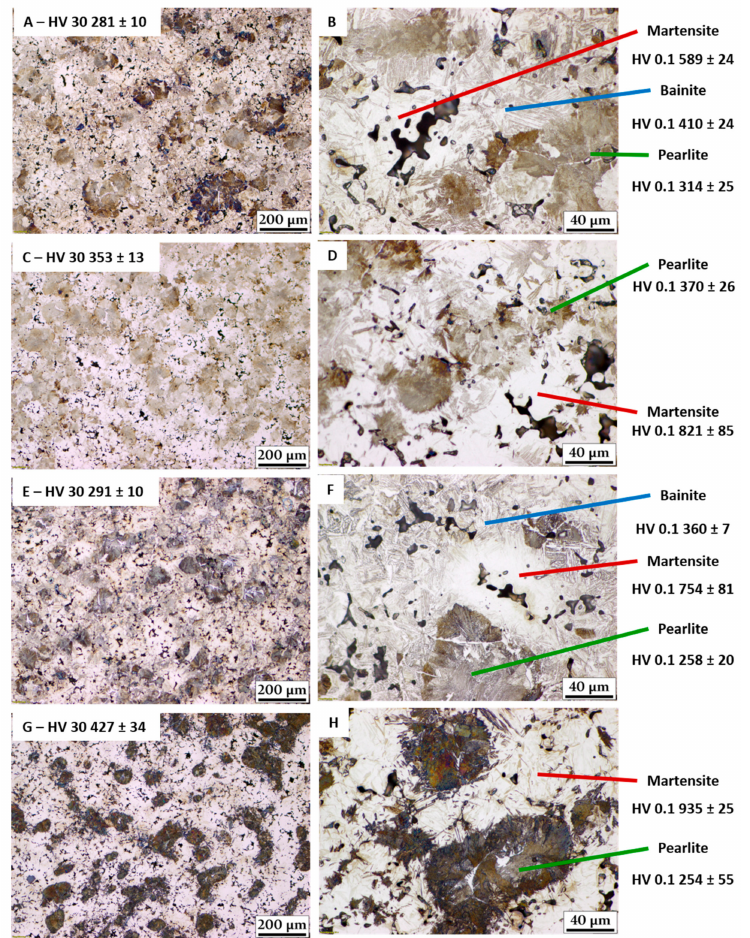
Figure 10. Metallographic sections of CCT samples cooled at 3 K/s in a final 15th run. 100 × ( left ), 500 × ( right ) ( A , B ) ASC + 4%CrMA1_0.6C nom (0.55C comb ), ( C , D ) ASC + 4%CrMA1_0.75C (0.64C), ( E , F ) ASC + 4%CrMA2_0.6C (0.54C), ( G , H ) ASC + 4%CrMA2_0.75C